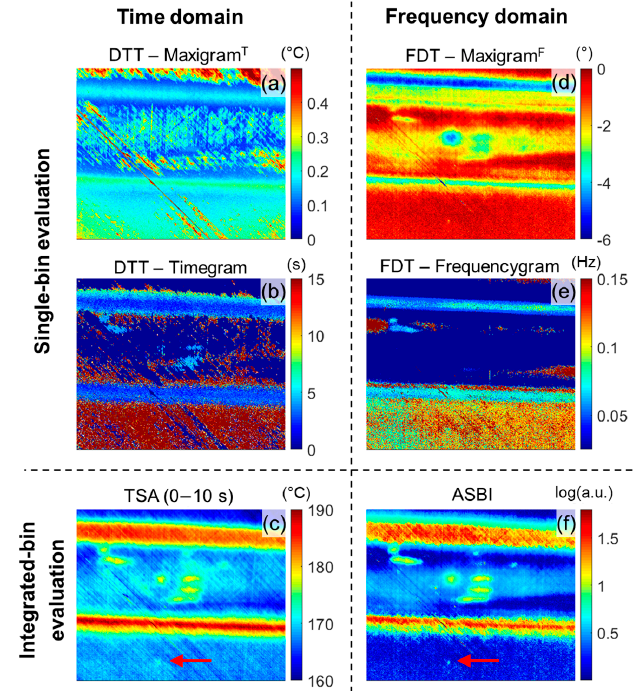
Figure 9. Results of processing techniques for the CFRP PROD aircraft panel: ( a , b ) DTT maxigram T Δ(cid:1846) (cid:3040)(cid:3028)(cid:3051) and timegram (cid:1872) (cid:2940)(cid:3021),(cid:3040)(cid:3028)(cid:3051) ; ( c ) TSA (0–10 s); ( d , e ) FDT maxigram F Δ(cid:2030) (cid:3040)(cid:3028)(cid:3051) and frequencygram (cid:1858) (cid:2940)(cid:3101),(cid:3040)(cid:3028)(cid:3051) ; and ( f ) ASBI damage index map.